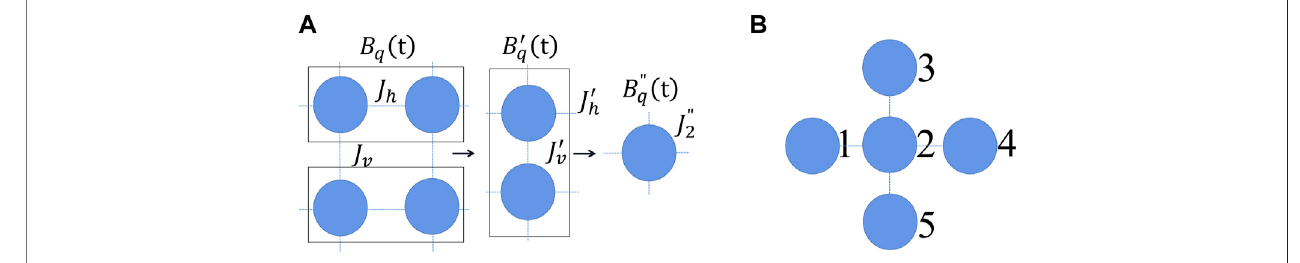
FIGURE3|(A) Theprocess ofthe2Dmodel partitioning, with fi rsthorizontal transformation and thenverticaltransformation. (B) Thebasicclusterwiththenearest neighbor interaction in the 2D